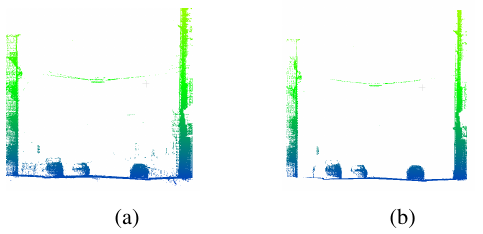
Figure 6. Rendered by height: (a) Raw data with noise (b) Cleaned